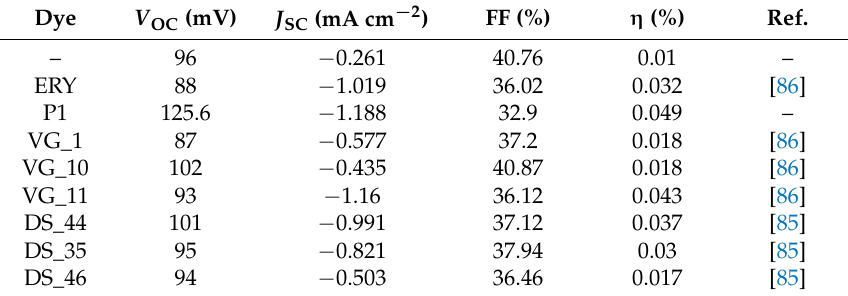
Table 3. Values of the relevant parameters’ open-circuit photopotential ( V OC ), short-circuit current density ( J SC ), fill factor (FF), and overall conversion efficiency ( η ), which characterize the photoelectrochemical performance of a p -DSC with a sensitized NiO photocathode. For the assembly of the DSC and the determination of the photoelectrochemical parameters, we adopted the experimental conditions reported in [97]. Data of the p -DSCs employing FG-sensitized NiO photocathodes could not be determined for the scarce time stability of the relative photoelectrochemical